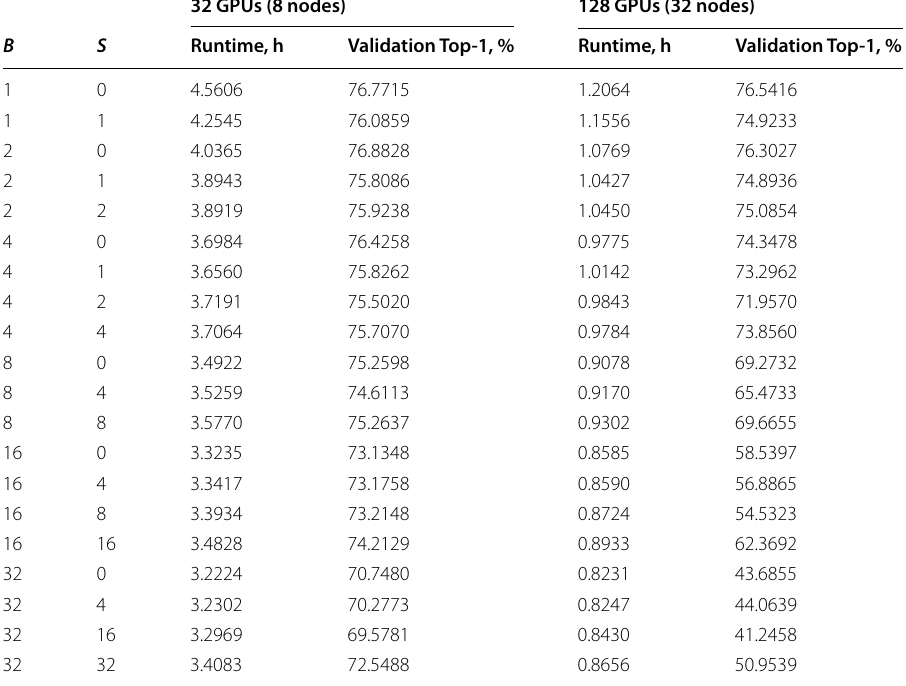
Table 2 Parameter study results. B is the number of forward-backward passes between global synchronizations and W is the number of batches to wait for the global synchronization data 32 GPUs (8